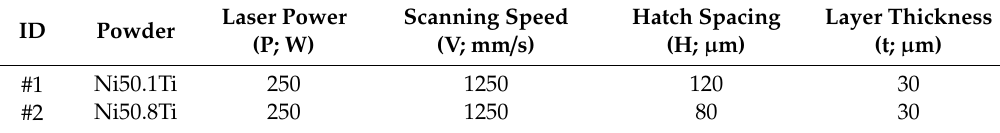
Table 1. The process parameters (PPs) of two series of selective laser melting (SLM) fabrication .